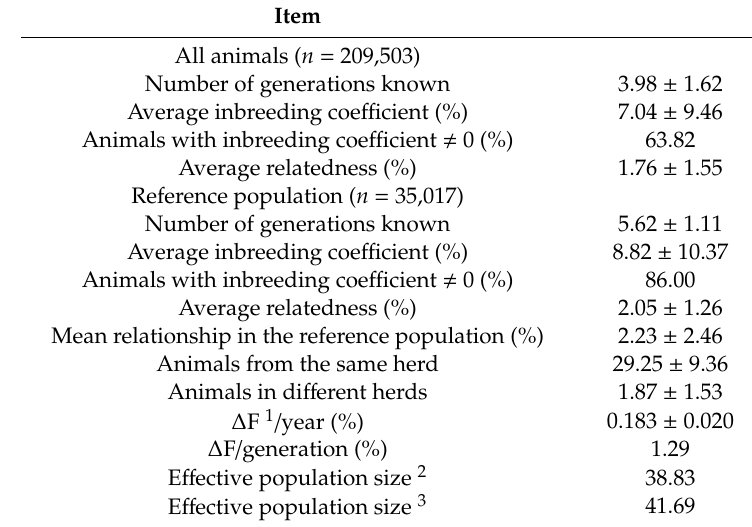
Table 2. Inbreeding and relationship coe ffi cients ( ± SD) for all animals and for the reference population (calves born between 2015 and 2019, n = 35,017).